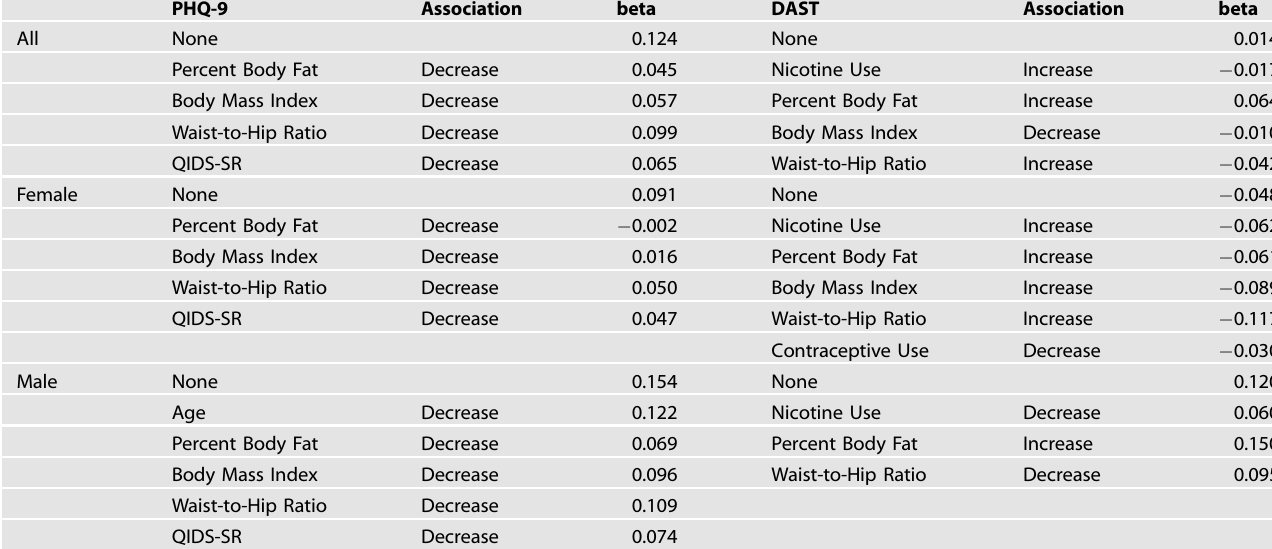
Table 3. Effect of Selected Confounders on Association with CRP and